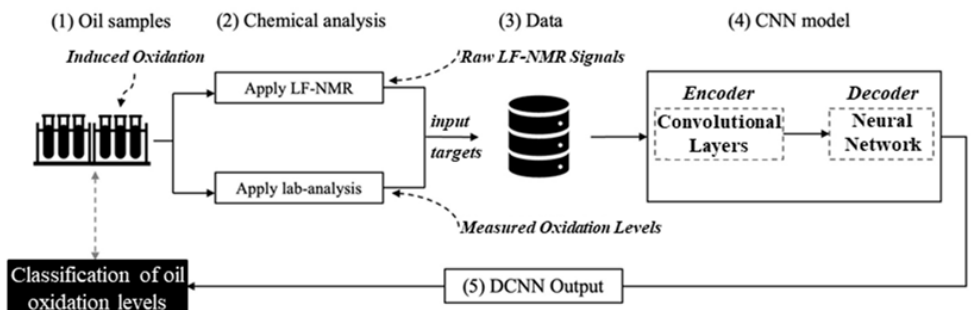
Figure 4. Training and testing system for machine learning: oil samples (1) are analyzed via low-field nuclear magnetic resonance (LF-NMR) and conventional lab methods (2) which are combined into a data frame of inputs and targets (3) for supervised learning via the convolution neural network (CNN) (4); the deep convolution neural network (DCNN) outputs, i.e., classification of T 2 signals into oxidation classes (5), are benchmarked against ground-truth measurements in order to assess prediction accuracy and to fine-tune the system in a series of recursive cycles until satisfactory accuracy is achieved. Having concluded system fine-tuning and training, the trained CNN is ready for deployment.